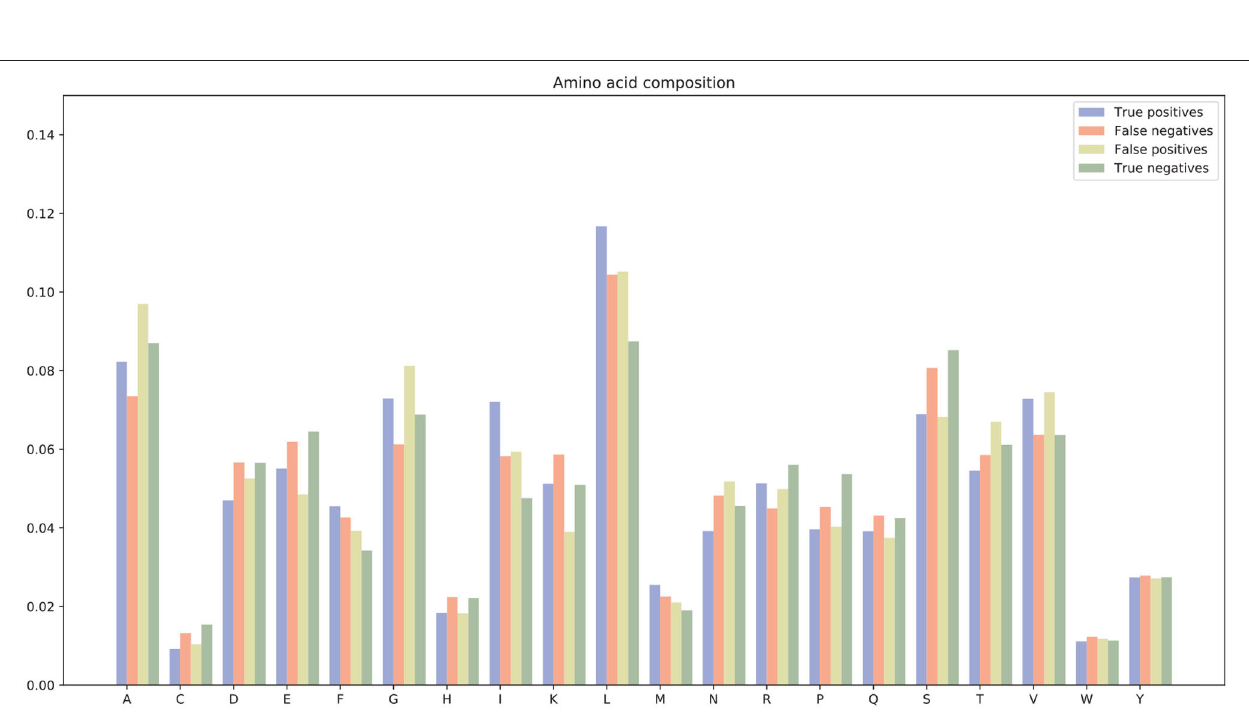
FIGURE 9 | Amino acid composition of samples in